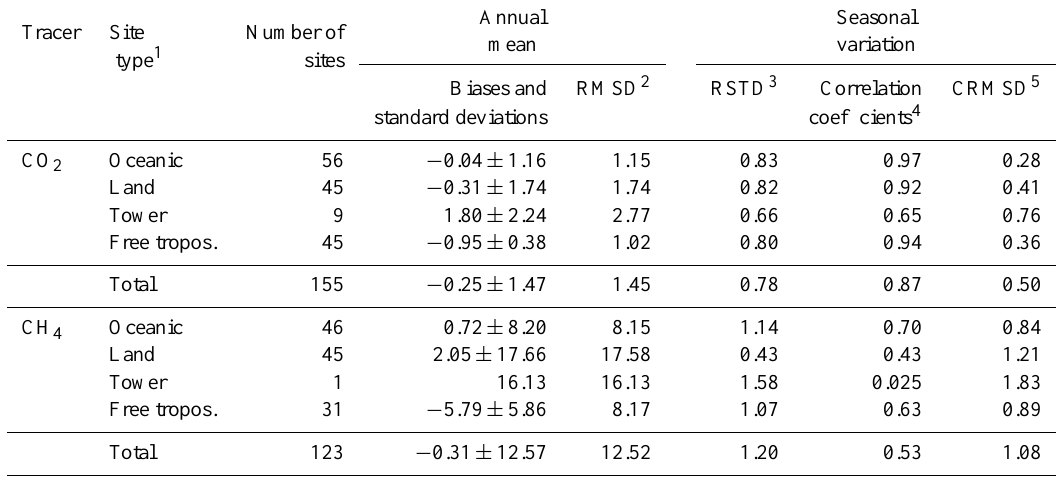
Table 1. Statistics to show the model performance against GLOBALVIEW analyses of CO 2 and CH 4 : annual-mean biases and seasonal